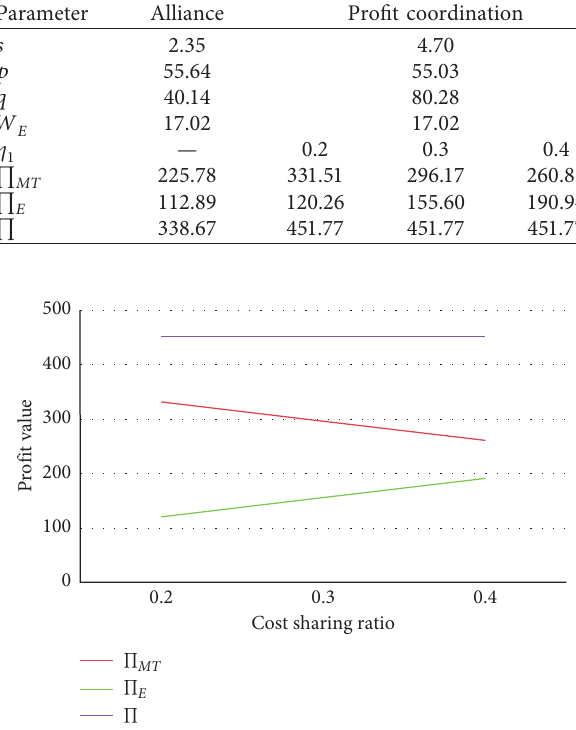
Figure 2: Sensitivity of cost sharing in semicentralized model 1.